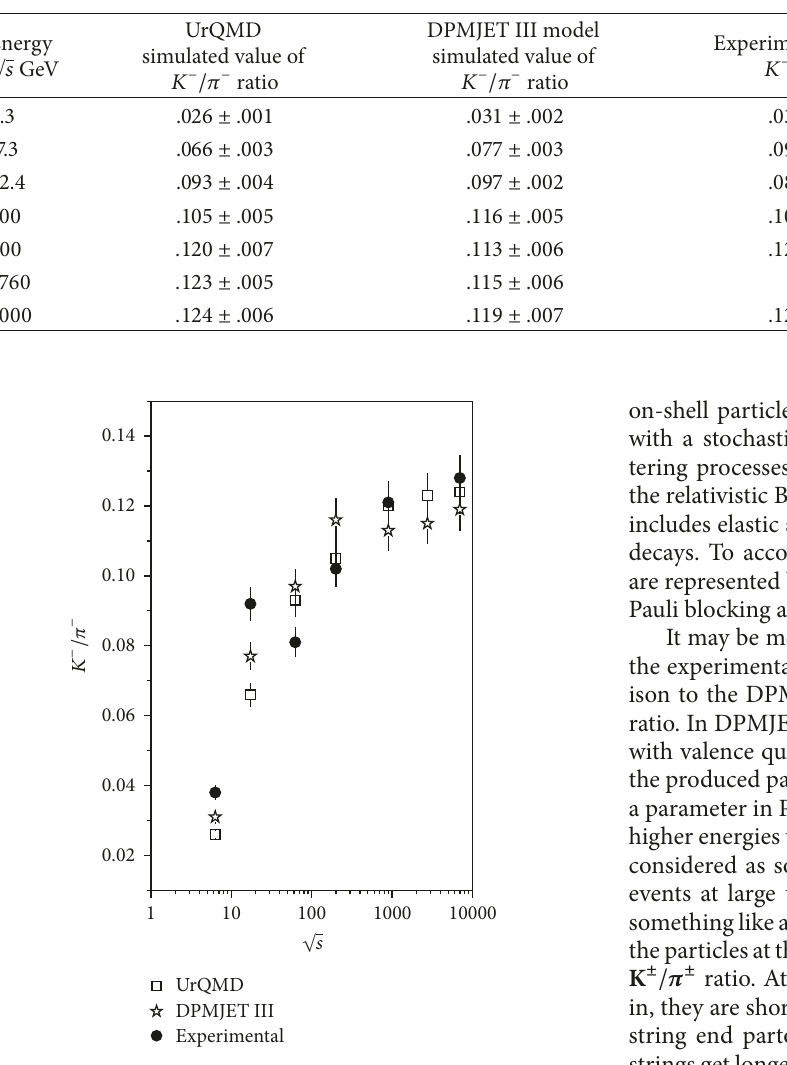
Table 2: It represents the values of 𝐾 − /𝜋 − ratio in pp collisions at √𝑠 = 6.3 GeV to 7 TeV in the framework of UrQMD, DPMJET III, and the experimental values.